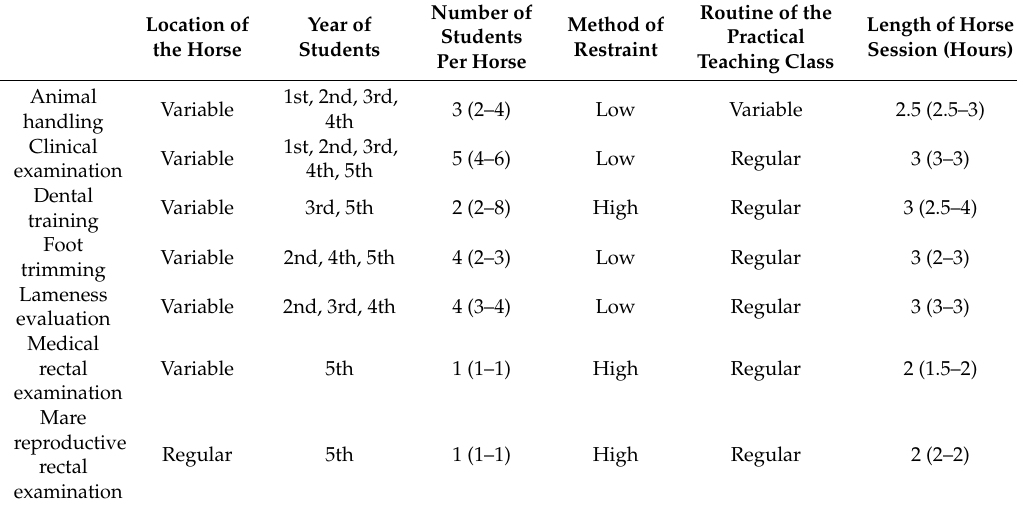
Table 3. Characteristics of each type of practical teaching class during the 2018 calendar year. The length of the horse session and the number of students per horse are presented with the median and interquartile range (IQR).